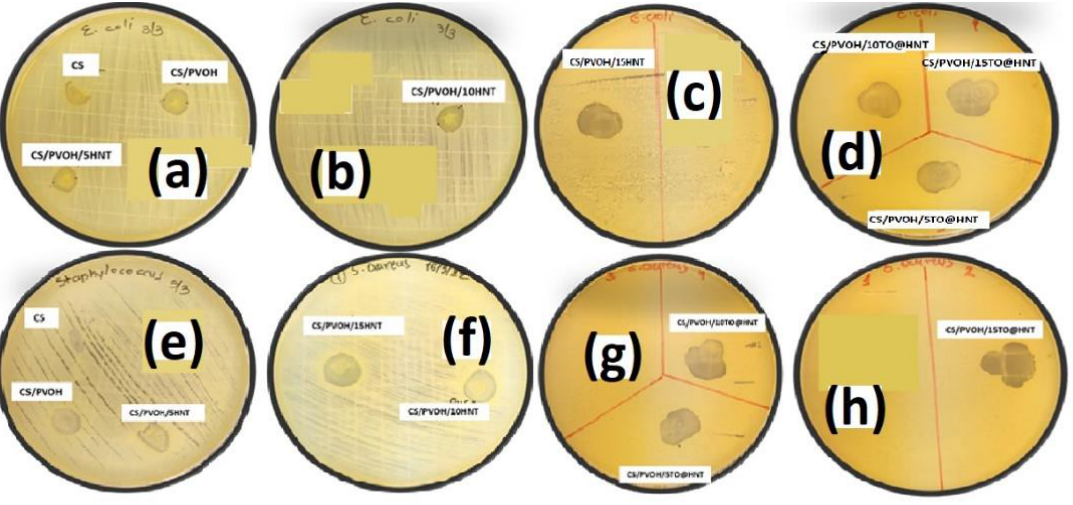
Figure 10. Petri dishes images of ( a – c , e , f ) CS, CS/PVOH, CS/PVOH/xHNT, and ( d , g , h )